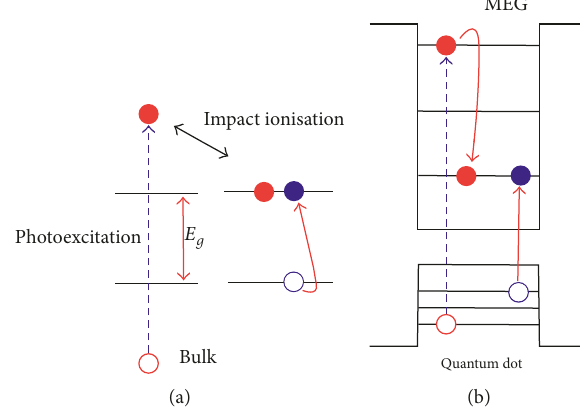
Figure 3: Generation of multiple excitons from highly excited electron-hole pairs. (a) In a bulk semiconductor, the excited electron relaxes to the bandgap. (b) In QD’s impact, ionisation is the inverse of the Auger process, and the rate of this is much larger than that in bulk. It is usually referred to as MEG in QDs, adapted from